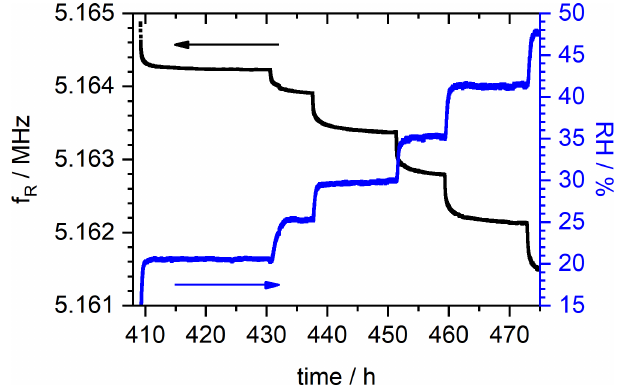
Figure 6. Resonance frequency course f R and relative humidity (RH) of the SPEEK film with DS = 0.9. For means of visibility, the depiction is limited to the measurement time between 409 and